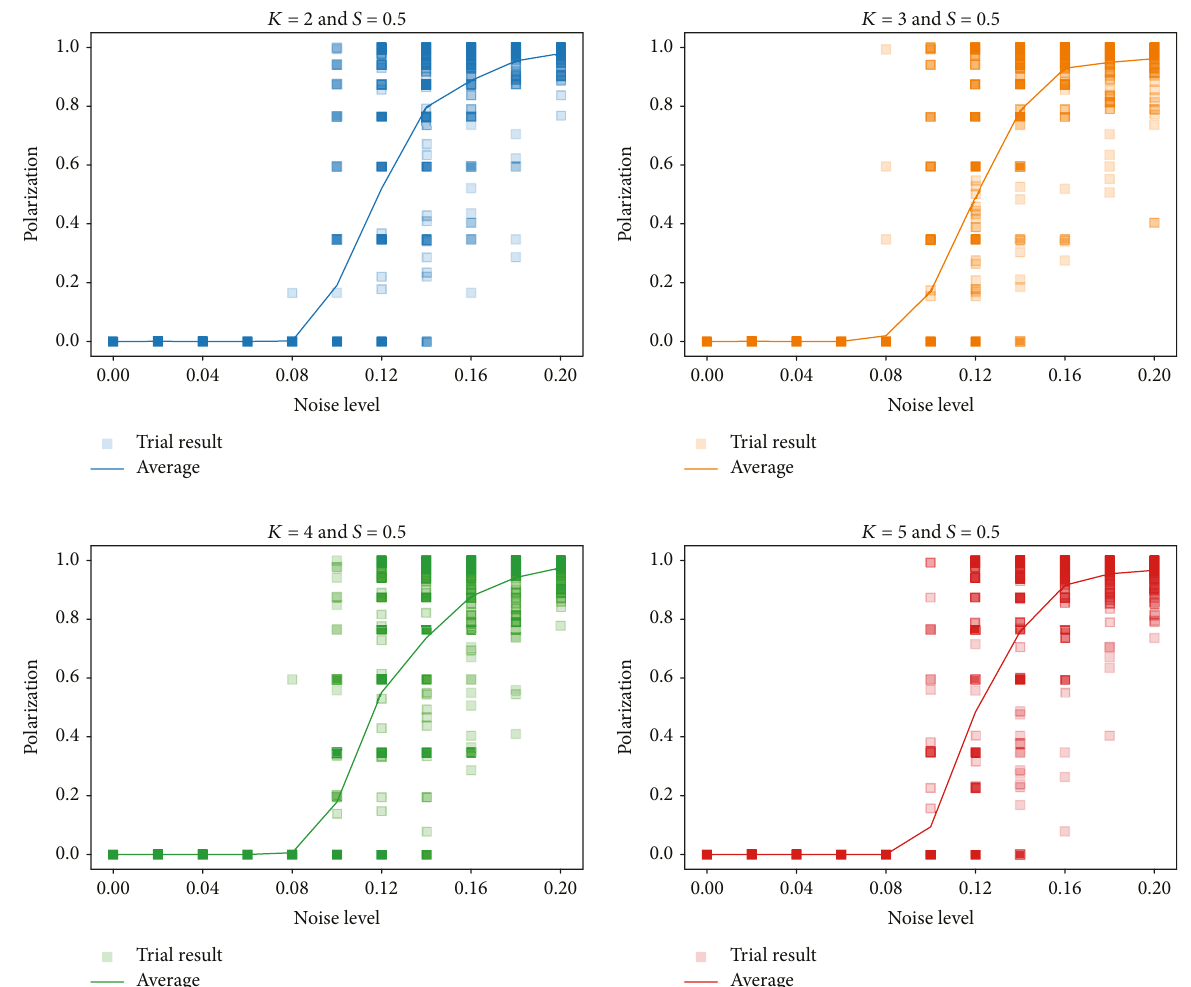
Figure 12: Final polarization of individual trial runs and averages from Figure 11 for S = 0 5 as a function of noise level, σ . As the noise level is increased, the system is increasingly biased towards larger fi nal polarization